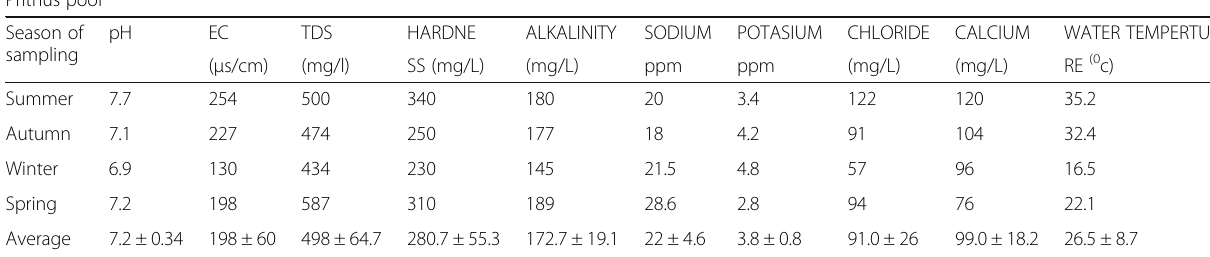
Table 8 Physico-chemical Parameters of Prithus Pool Prithus